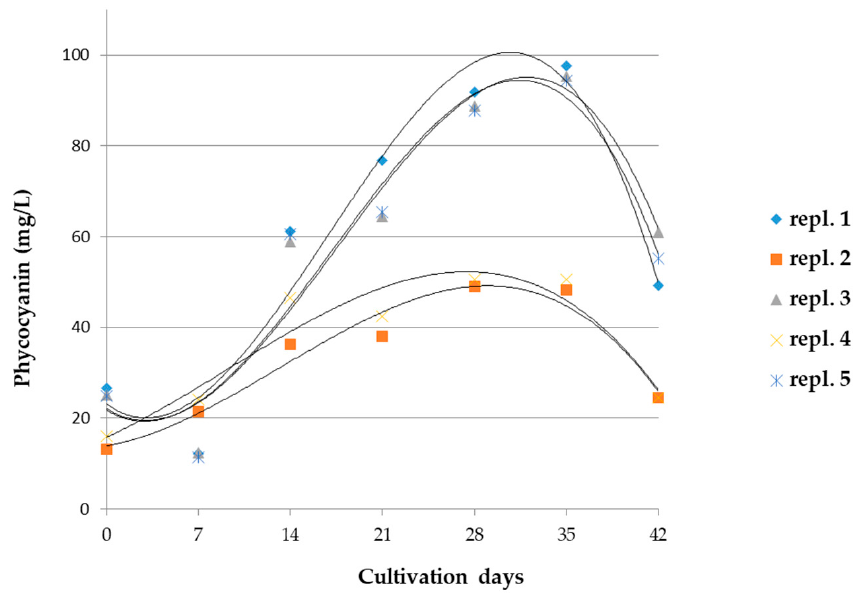
Figure 3. Phycocyanin concentration values in A. maxima samples, taken every 7 days in 2 reference cultivations. n = 5. Statistical data and parameters are reported in Supplementary Table S1D.